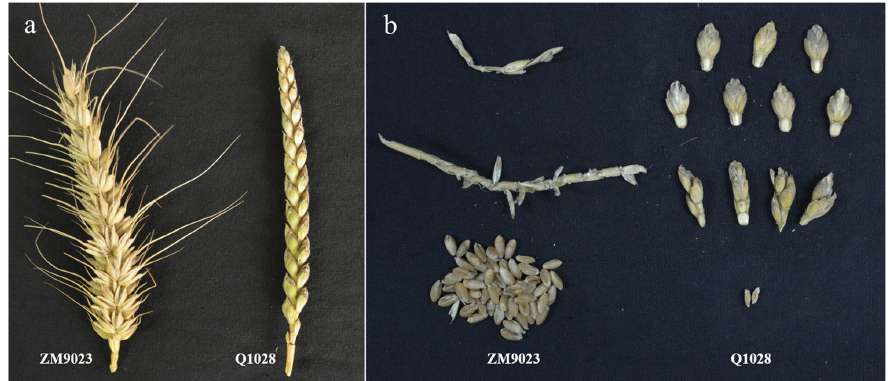
Figure 1. Spikes and phenotypes after mechanical threshing. a Comparison of spikes between ZM9023 and Triticum aestivum ssp. tibetanum Shao accession Q1028. b The phenotypes after mechanical threshing between ZM9023 and Triticum aestivum ssp. tibetanum Shao accession Q1028 showed significant difference both in brittle rachis and threshability.